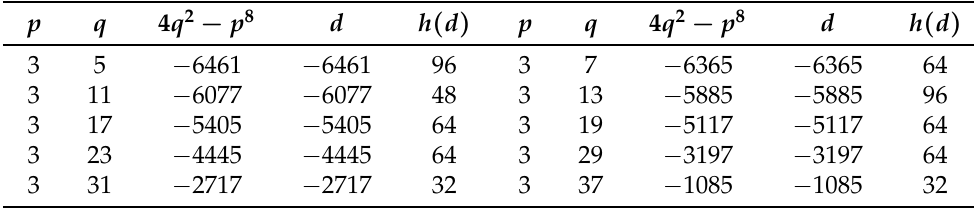
Table 6. Numerical examples for n =